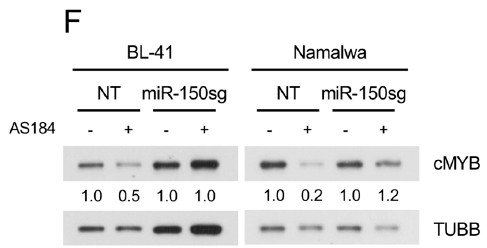
Figure 6. AS1842856 regulates MYB through upregulation of miR-150 ( A ) AS does not reduce MYB RNA levels. BL cells were treated with AS or DMSO. Treated cells were harvested after 24 h and RNA expression levels were analyzed by qRT-PCR. qRT-PCR data were quantified by the 2 − ∆∆ CT method. Data are shown as mean ± SD ( n = 3). ( B ) AS does not induce MYB protein degradation. BL cells were treated with 10 µ g / mL CHX and harvested 0–8 h later. Expression of MYB was analyzed by immunoblot. Expression levels of TUBB served as loading control. A representative of 2 independent experiments is shown. Densitometric quantification of MYB / TUBB protein levels was done with ImageJ software (https: // imagej.nih.gov / ij / , RRID: SCR_003070). ( C ) AS induces miR-150 transcription. BL cells were treated with AS or DMSO. Treated cells were harvested after 3 days, followed by miRNA isolation and miRNA cDNA generation as described in Supplemental Methods. miRNA expression levels were analyzed by qRT-PCR. qRT-PCR data were quantified by the 2 − ∆∆ CT method. Data are shown as mean ± SD ( n = 3). ( D – F ) BL cell lines were transduced with lentiviral vectors expressing a miR-150 CRISPR / Cas9 knockout construct or a non-targeting control (NT) and FACS sorted. ( D ) miRNA was isolated and miRNA cDNA was generated 4 days post transduction as described in Supplemental Methods. miRNA expression levels were analyzed by qRT-PCR. qRT-PCR data were quantified by the 2 − ∆∆ CT method. Data are shown as mean ± SD ( n = 3). ( E ) miR-150 knockout construct is functional. Genomic DNA was isolated 4 days post transduction and the miR-150 locus was amplified as